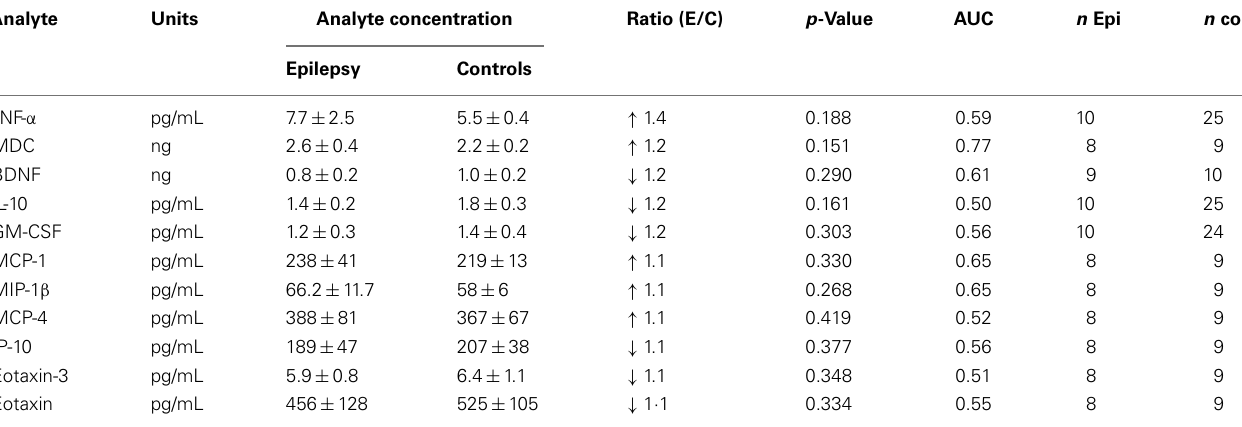
Table 3 | Levels of cytokines and chemokines in plasma that do not significantly distinguish between epilepsy patients and controls. Analyte